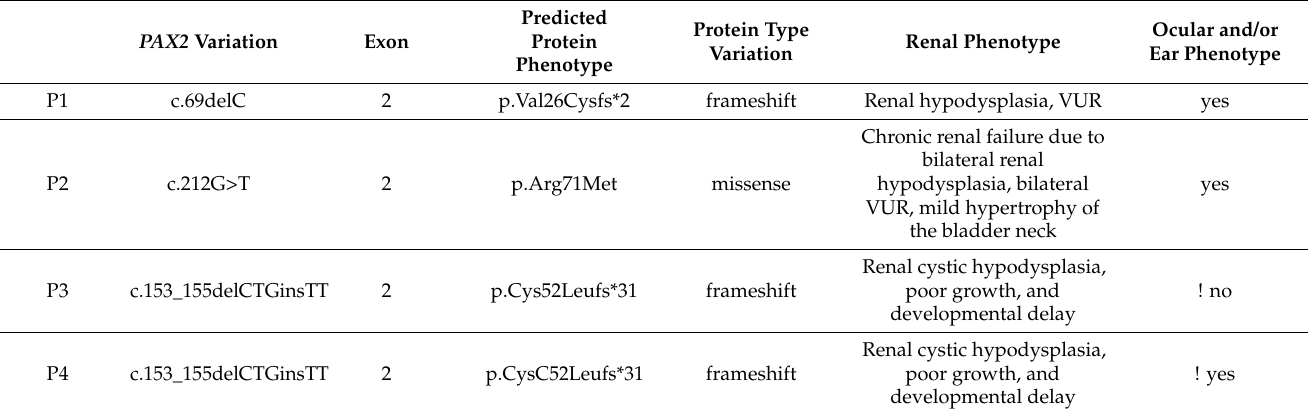
Table 2. Variants highlighted in the four patients and the associated phenotypes.